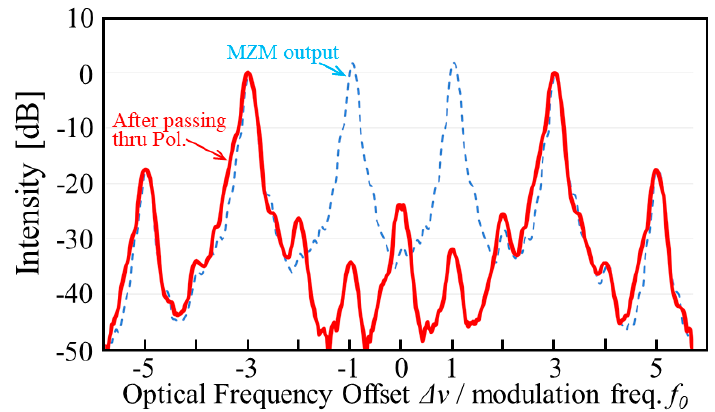
Figure 6. Optical spectrum of 60-GHz separation OTT signal (Solid red line) composed of strongly